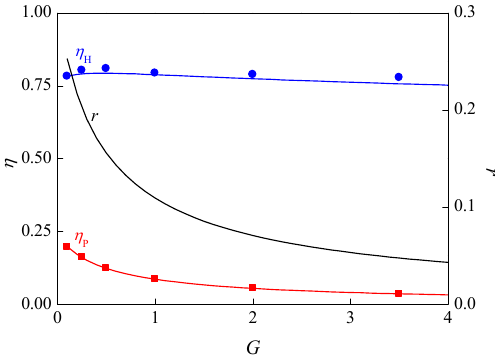
Figure 5. Results of the two efficiencies η (left y ‐ axis) and power to heat ratio r (right y ‐ axis) for varied gap G in configuration 1.